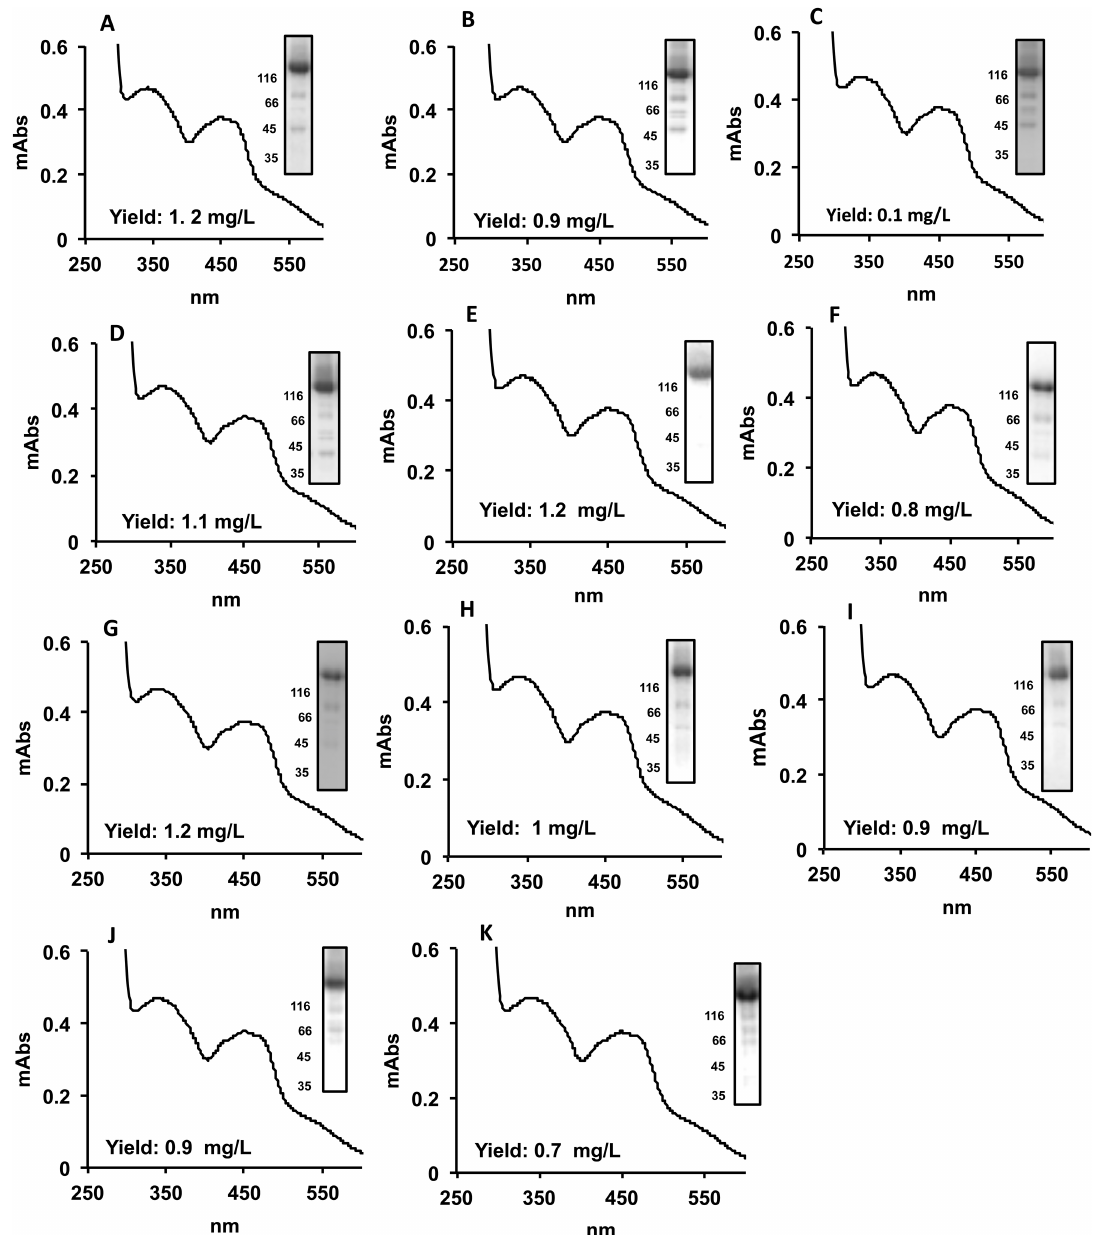
Fig 2. Characterization of the hAOX1 SNP-based variants. The main graphs illustrate the UV-Vis spectra of the indicated proteins isolatedfrom E . coli . The UV-Vis spectra were recordedusing purifiedair-oxidized hAOX1 proteins in 50 mM Tris, pH 8.0. The yield of protein after purification is indicated. (A) hAOX1 WT; (B) hAOX1 G46E; (C) hAOX1 G50D; (D) hAOX1 G346R; (E) hAOX1 H363Q; (F) hAOX1 R433P; (G) hAOX1 A437V; (H) hAOX1 L438V; (I) hAOX1 A439E; (J) hAOX1 hAOX1 R1231H;(K) hAOX1 K1237N.The 10% SDS-polyacrylamidegels of the indicatedproteins after staining with Coomassie blue are shown in the rightmost inset of each panel. The majority of the lower bandsshown in the SDS-PAGE gels were identified by mass spectrometry as degradationproducts of hAOX1 as reportedbefore (Hartmannet al., 2012).